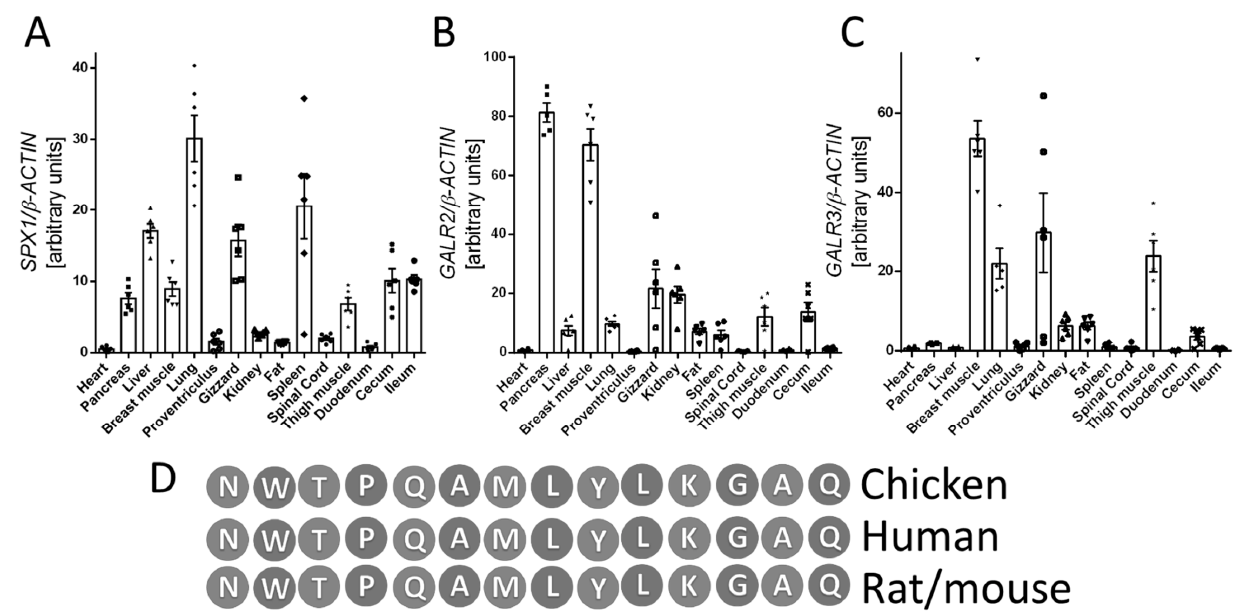
Figure 1. mRNA expression of SPX1 ( A ), GALR2 ( B ), and GALR3 ( C ) genes in various chicken tissues. Comparison of SPX amino acid sequences in chickens, humans, mice, and rats ( D ). Results (graph: A – C ) are shown as the means ± SEMfor each value ( n = 6). The dots and symbols represent the individual values obtained.